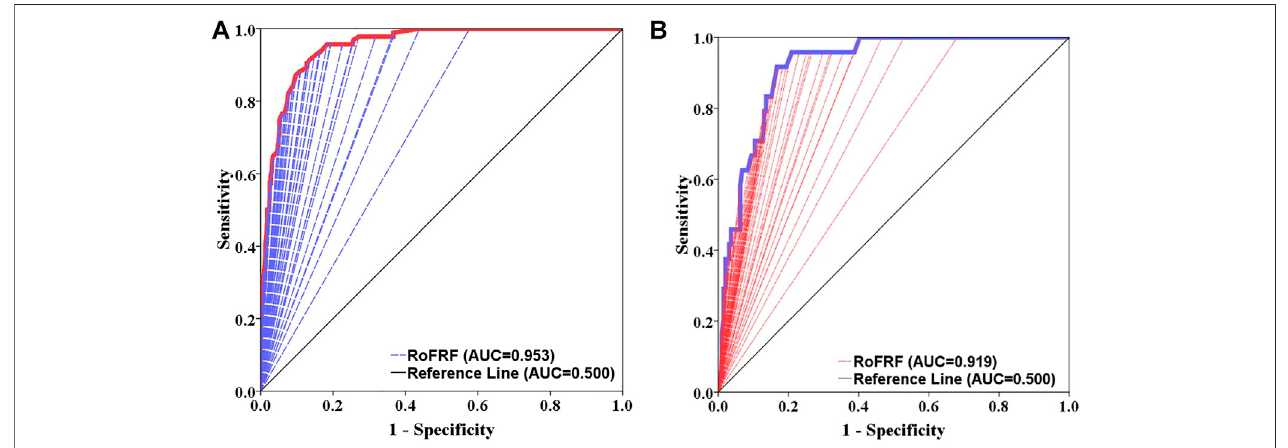
FIGURE 6 | Performance and prediction accuracy of the RoFRF model using ROC curve (A) training dataset, (B) validation dataset.